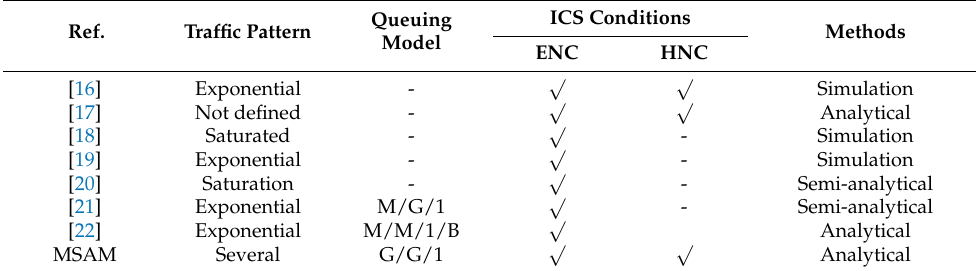
Table 1. Comparison of the main contributions of the related works.